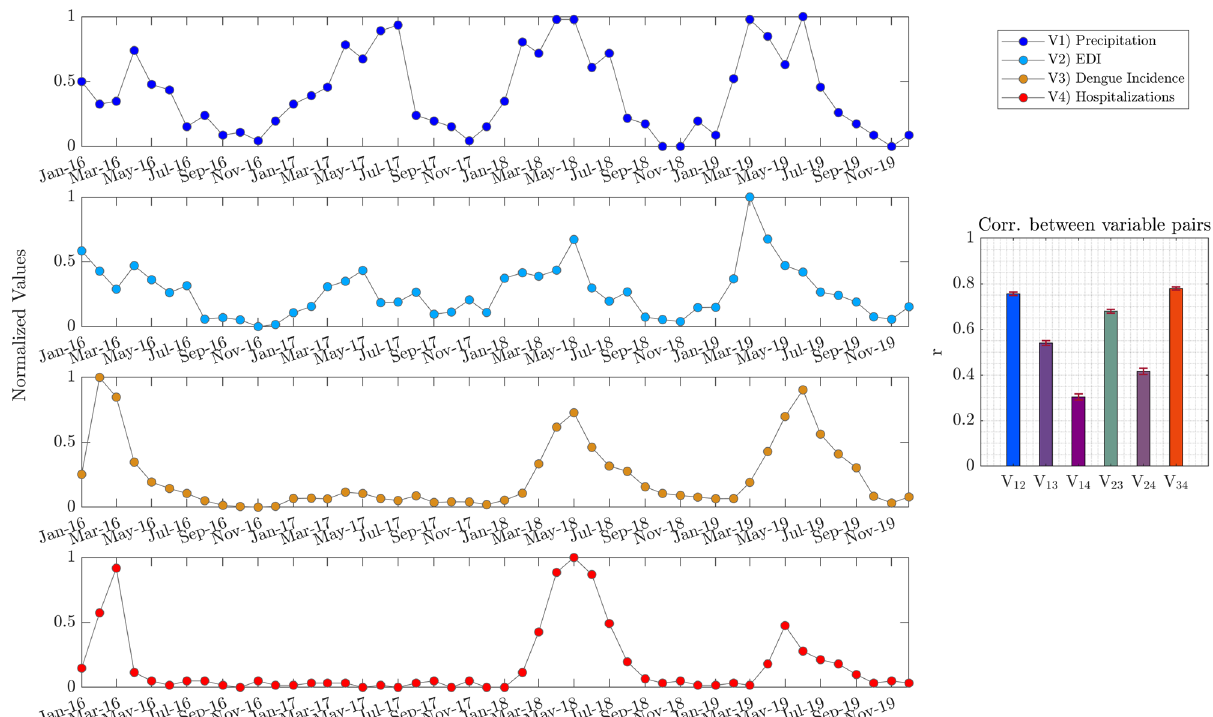
Figure 5. Time series by monthly accumulated values and its pairwise associations. The time series represents the normalized values (0–1 scaling) of Precipitation, EDI, Dengue Incidence, and Hospitalizations, each colored differently. The right panel represents a pairwise similarity among the analyzed variables; the similarity was estimated by computing the correlation coefficient between randomly selected samples (100 times); the bar height represents mean values, and whiskers represent standard